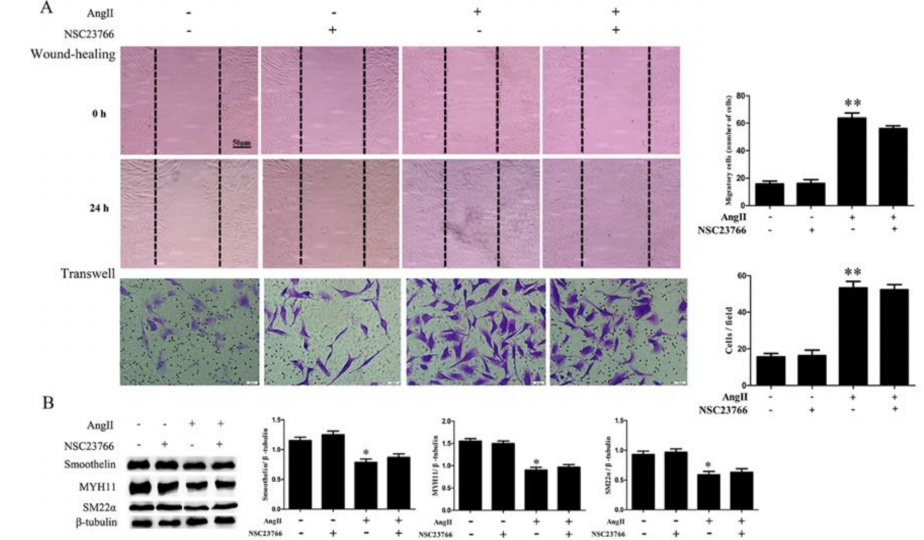
Figure 5. The e ff ects of Rac1 inhibitor NSC23766 on cell migration and the expression of contractile marker proteins in HA-VSMCs. Cells were pretreated with NSC23766 (50 µ M) for 30 min and then exposed to 100 nM Ang II for 24 h. Untreated cells were used as the control. ( A ) Cell migration was detected by wound-healing and Transwell assays. Histograms show the quantification of the wound healing and Transwell assay results. The scar bar is 50 µ m. ** p < 0.01 vs. the control group ( n = 3). ( B ) Western blot analysis of MYH11, SM22 α , and smoothelin. Histograms show the ratios of MYH11 or SM22 α or smoothelin to β -tubulin. * p < 0.05 vs. the control group ( n =